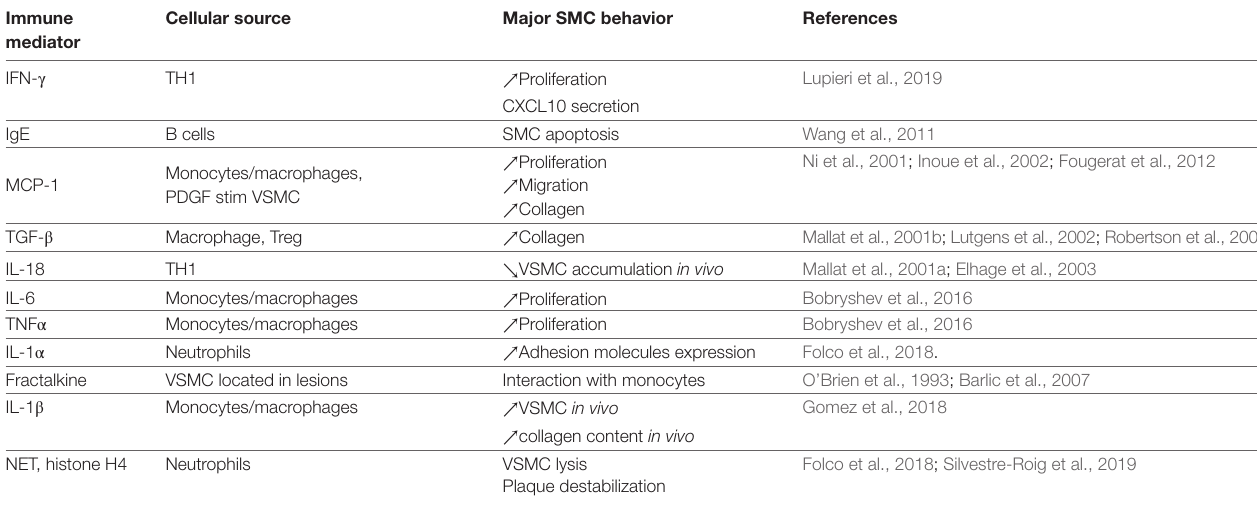
TABLE 1 | List of major immune mediators impacting VSMC behavior during